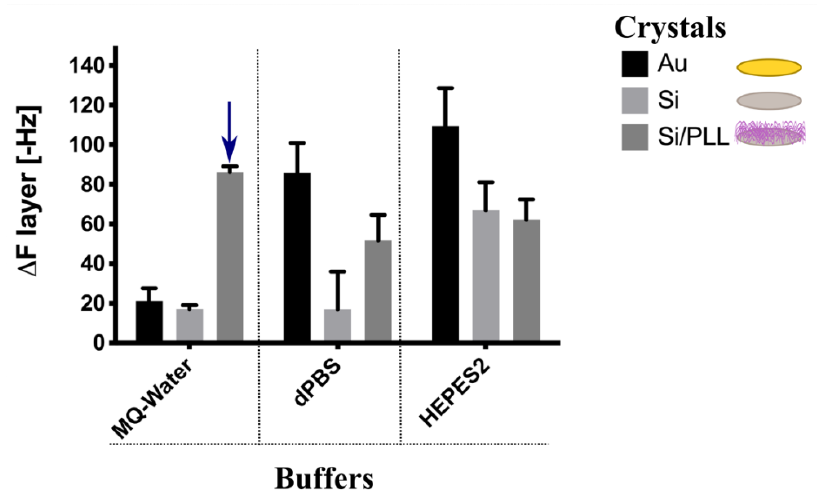
Figure 4. Immobilization analysis on surfaces of PEG-NEs. QCM-D frequency changes upon binding of PEG-NEs to different surfaces (crystals used: gold (Au), silica (Si), and silica/polylysine; Si/PLL) using different buffers (MQ-water, dPBS, and HEPES2). Values represent mean ± SD ( n = 2). Blue arrow indicates the condition chosen.